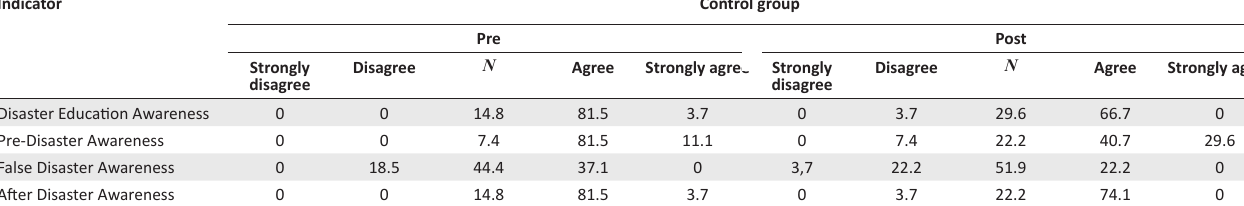
TABLE 5: Percentage of urban students’ responses from control groups. Indicator